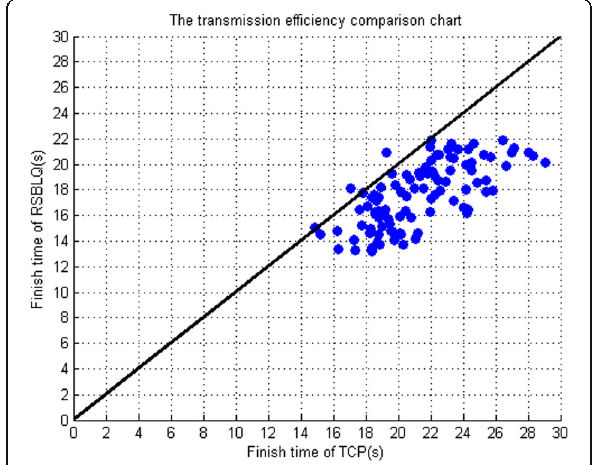
Fig. 10 The transmission efficiency comparison with TCP